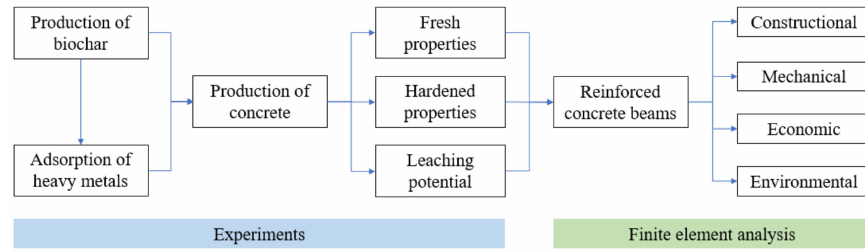
Figure 1. Illustration of the methods adopted in this